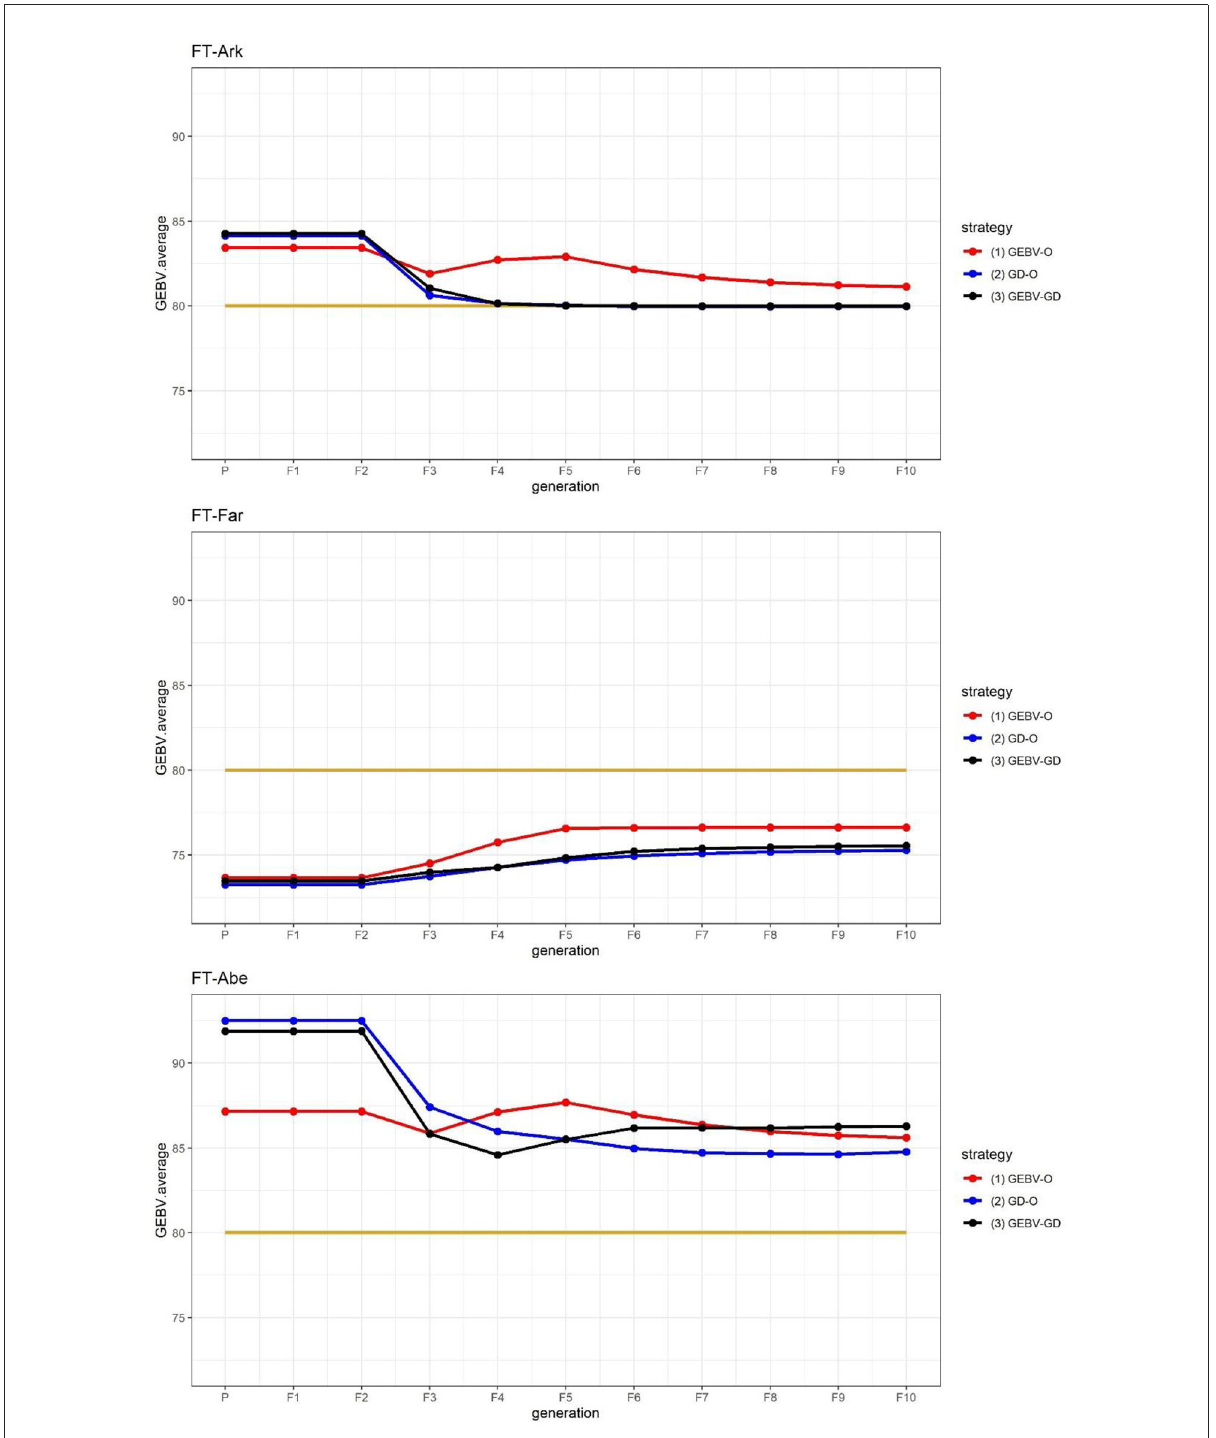
FIGURE3 GEBV averages of the best individuals at each generation for the 44k rice dataset based on the index weights of 0.3, 0.4, and 0.3. GEBV-O, Subset of the 10 accessions with the highest selection index values; GD-O, Subset of the 10 accessions with the maximal D -scores chosen from the candidate set S c ; GEBV-GD, Subset of the top two accessions with the highest selection index values, and another eight accessions chosen from the reminder of S c . FT-Ark, flowering time in Arkansas; FT-Far, flowering time in Faridpur; FT-Abe, flowering time in